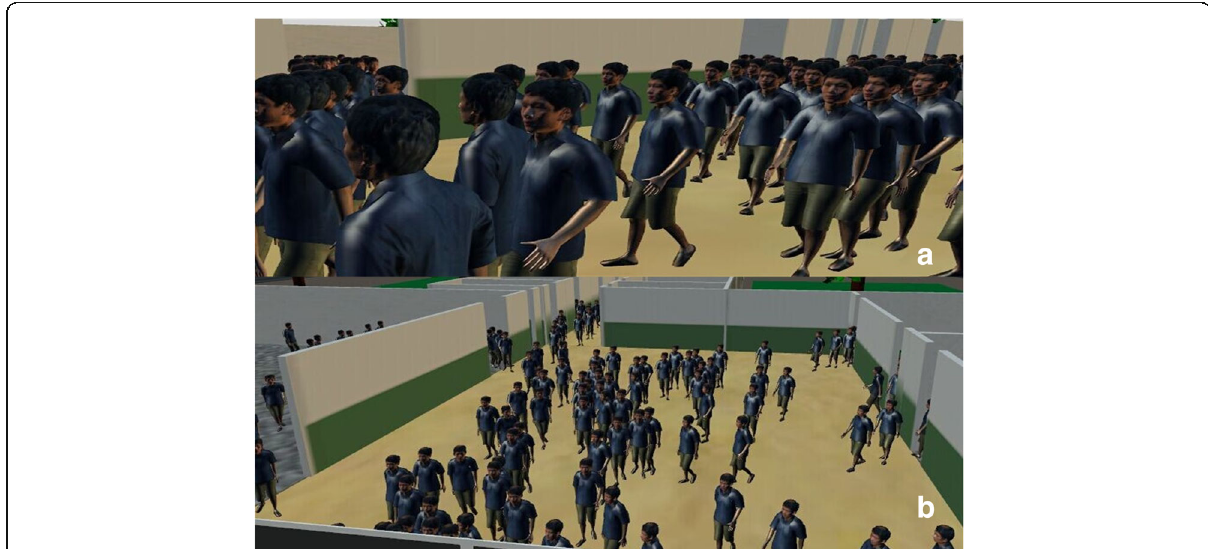
Fig. 13 The application of simplified model in school